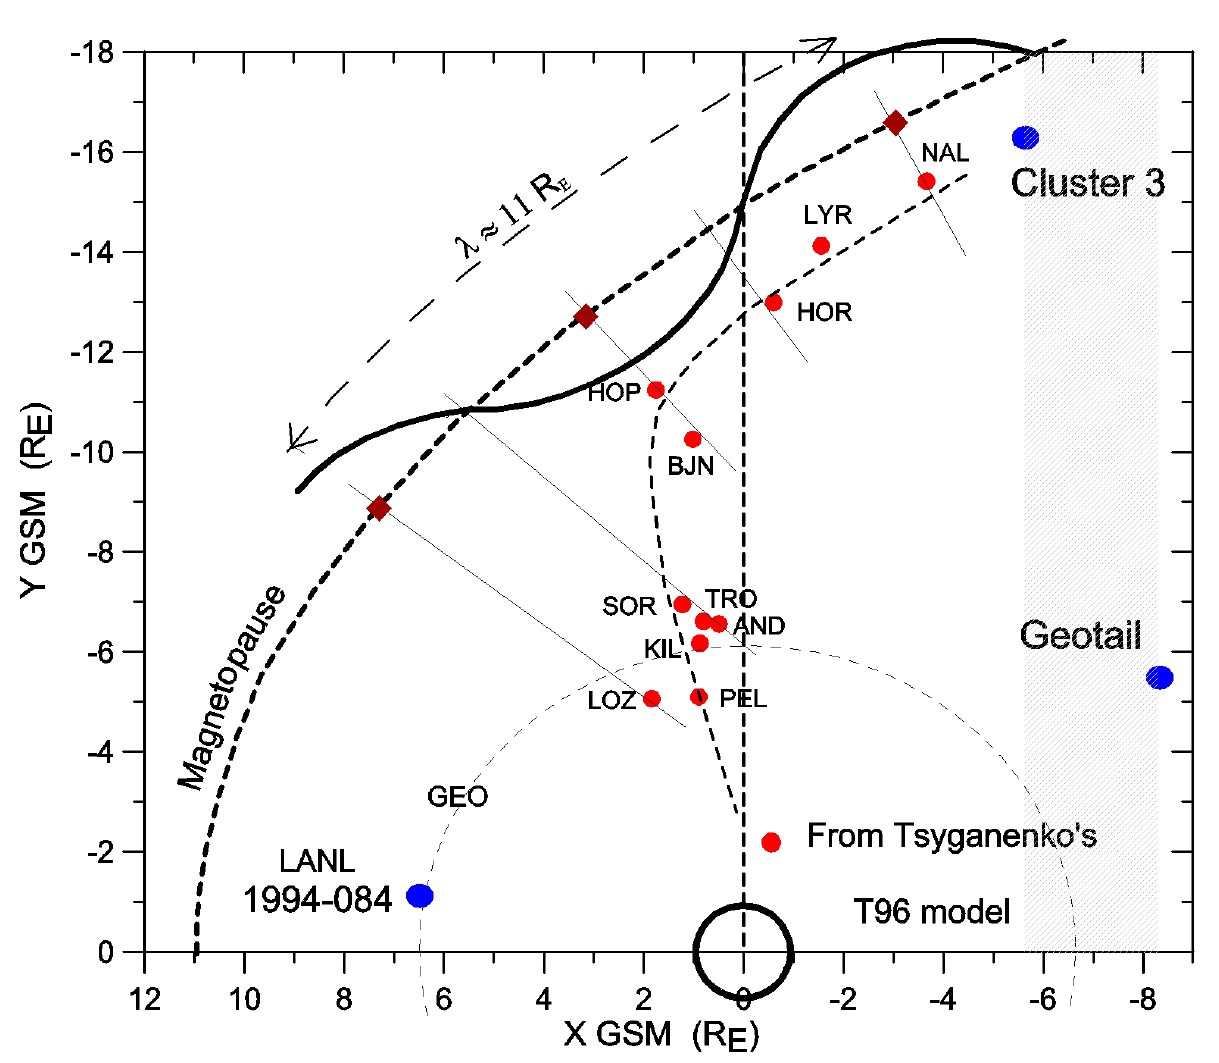
Fig. 4. Cluster 3, Geotail and LANL 1994-084 satellite positions, projected over the XY plane, are shown for the event of day 179, 2001, at 04:30 UT. The points NAL, LYR, HOR, HOP, BJN, SOR, TRO, AND, KIL, LOZ and PEL are determined via the T96 model as the conjugate points of these ground stations over the XY GSM plane. For this event, the magnetopause surface wavelength is ∼ 11 R E , and therefore different stations are associated with different amounts of magnetopause surface